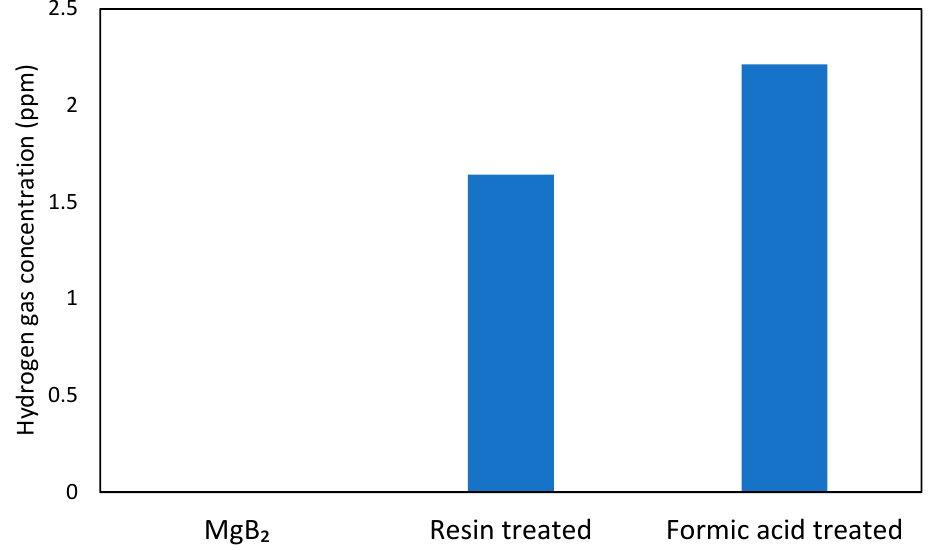
Figure 5. Hydrogen release from as-deposited MgB 2 and ion-exchanged thin films under UV irradiation.